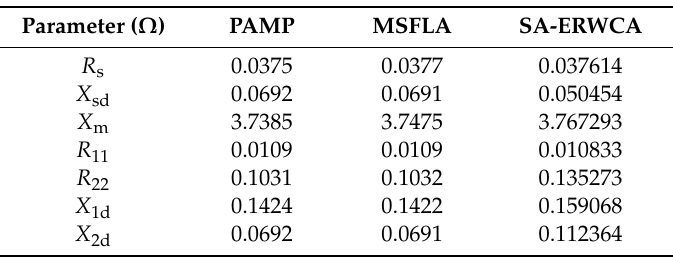
Table 12. Results for PAMP, MSFLA and SA-ERWCA for Machine 2.